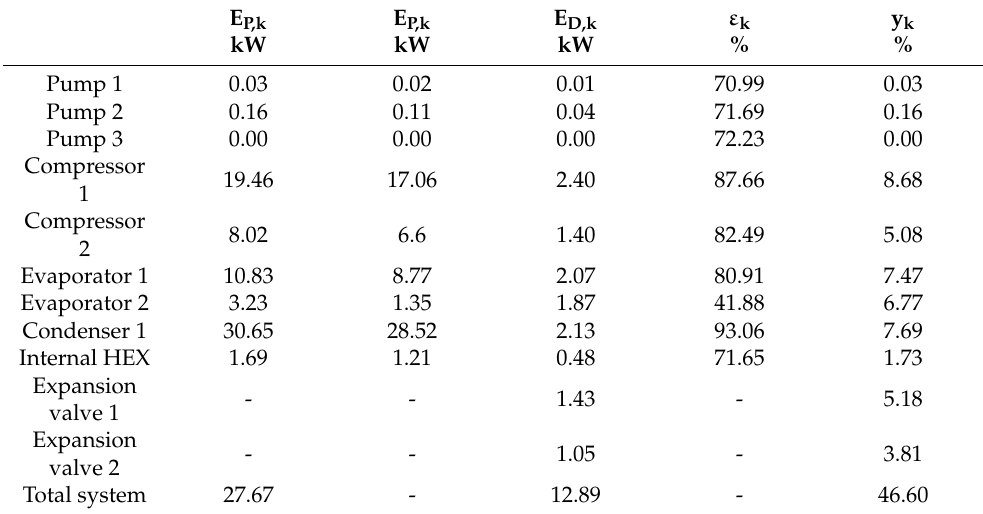
Table A6. Exergy calculation results of case